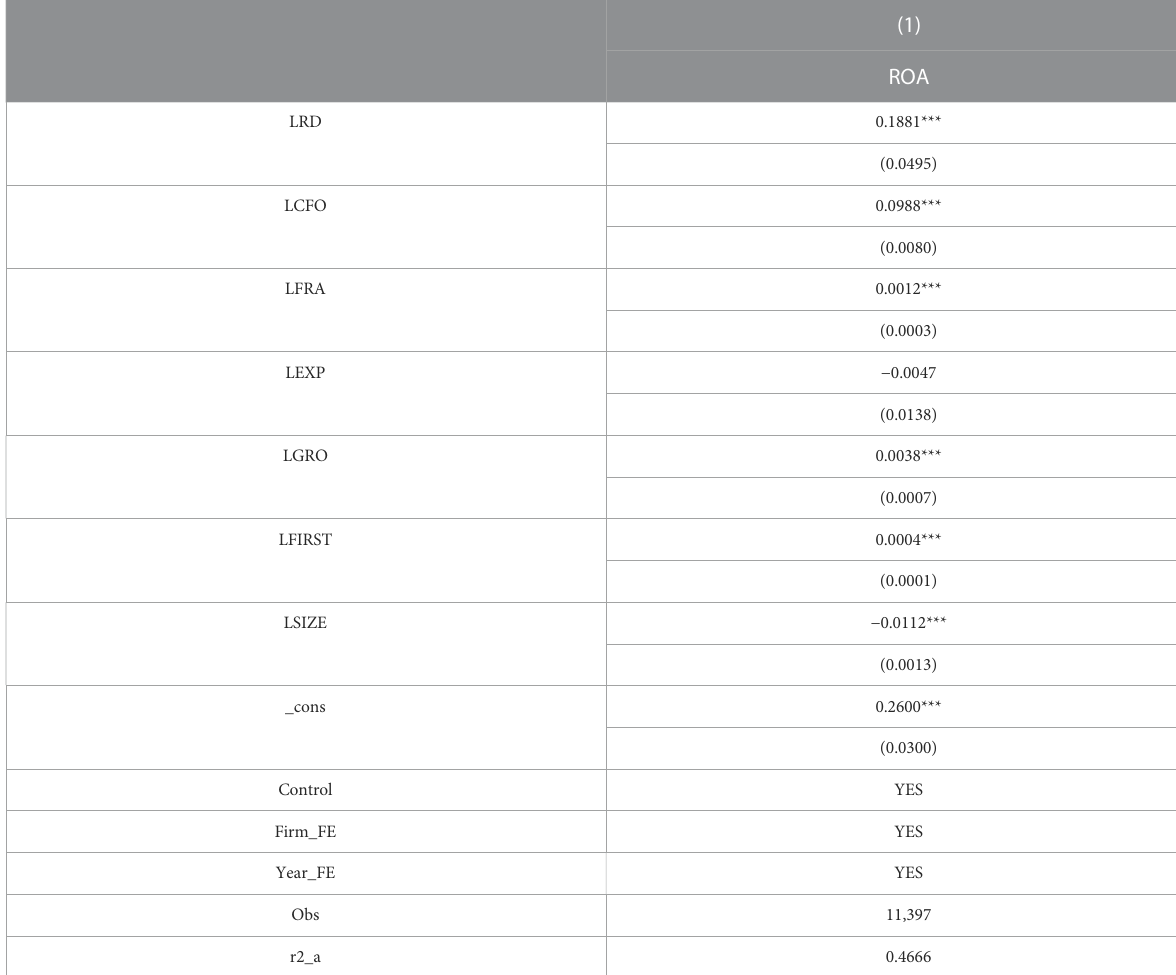
TABLE 5 Robustness test